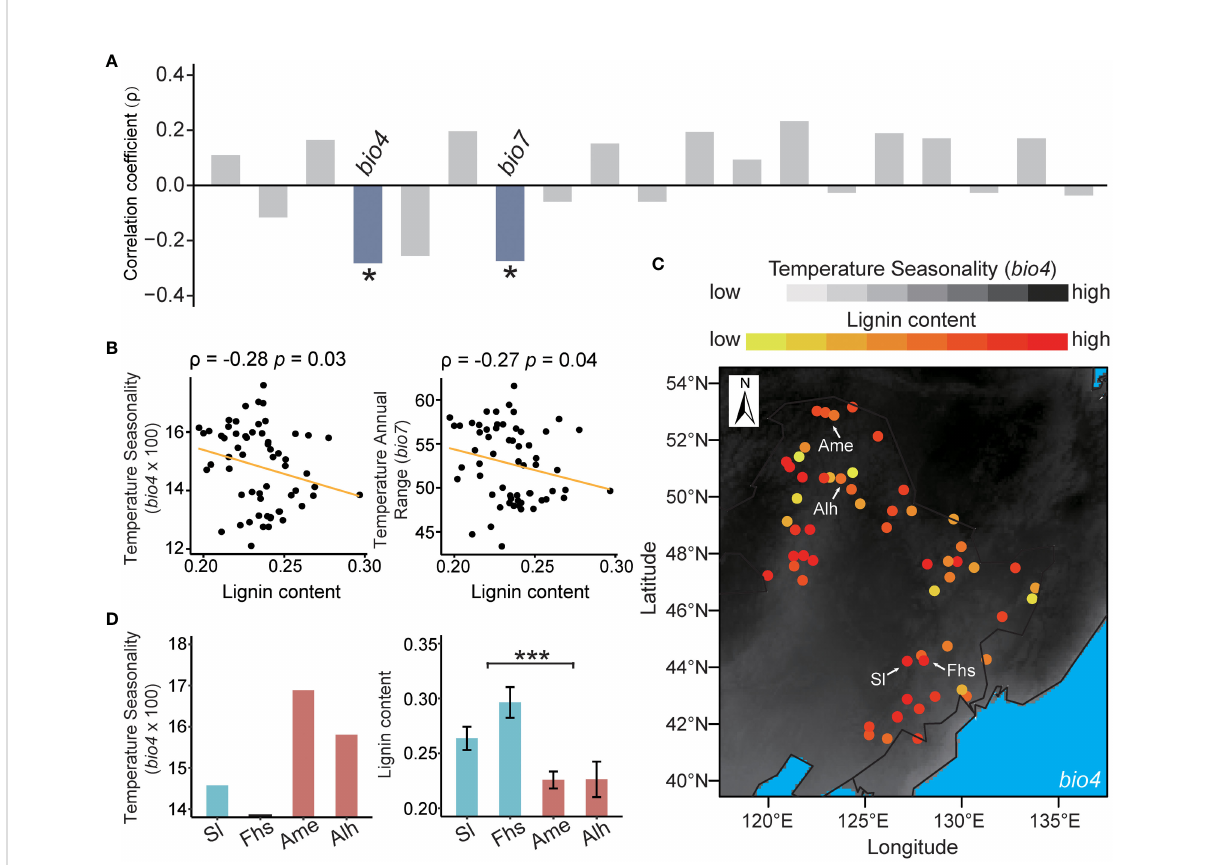
FIGURE 1 Correlations between lignin content and climatic variables. (A) Partial correlations between lignin content and 19 climatic variables. The correlation coef fi cients ( r ) in blue bar mean the lignin content is signi fi cantly negatively correlated with the indicated climatic variables, and those in grey mean the lignin content is not signi fi cantly correlated with the indicated climatic variables. (B) Distribution of lignin content with Temperature Seasonality ( bio4 ) and Temperature Annual Range ( bio7 ). The segmental line in orange represents the partial correlation fi t of lignin to an indicated climatic variable. (C) Visualization of the relationship between lignin content and bio4 in the northeast China. The color of the point in background re fl ects the value of bio4 , with darker for a higher value and lighter for a lower value. The color of sampling sites re fl ects the content of lignin, with a redder color for a higher content and vice versa . The symbols “ Sl ” , “ Fhs ” , “ Ame ” , and “ Alh ” referred to the sample from different sampling sites, namely “ Shulan ” , “ Fenghuangshan ” , “ Amuer ” , and “ Alihe ” . (D) Comparisons of Temperature Seasonality ( bio4 ) and the lignin content in Sl, Fhs, Ame, and Alh. The p ≤ 0.05 is marked as ‘ * ’ , and p ≤ 0.001 is marked as ‘ *** ’